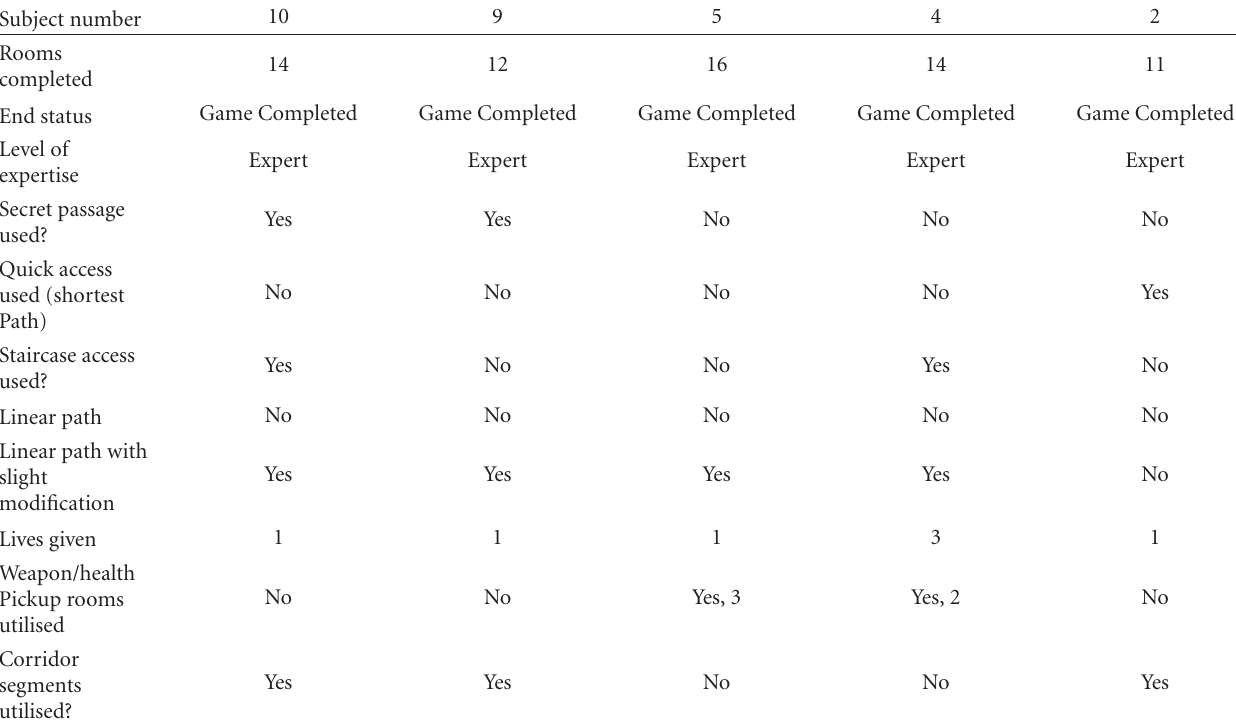
Table 1: Fundamental information regarding the five best players.